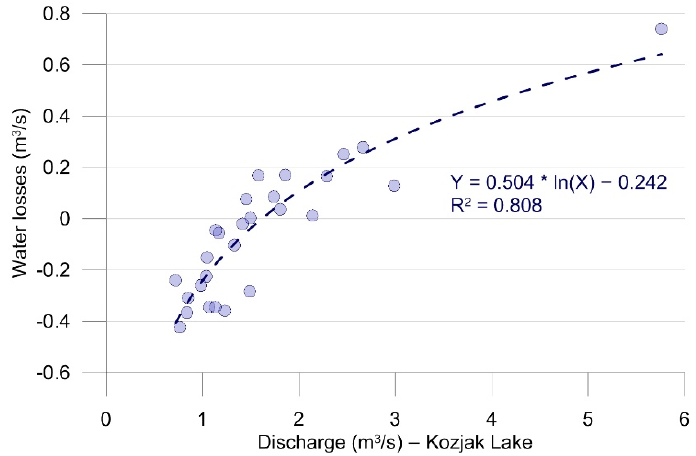
Figure 8. Analysis of the correlation between the losses of water (m 3 /s) from Kozjak Lake and the discharges measured at the exit from Kozjak Lake, according to the results of discharge measurements (1979–1987 and 2015–2020).